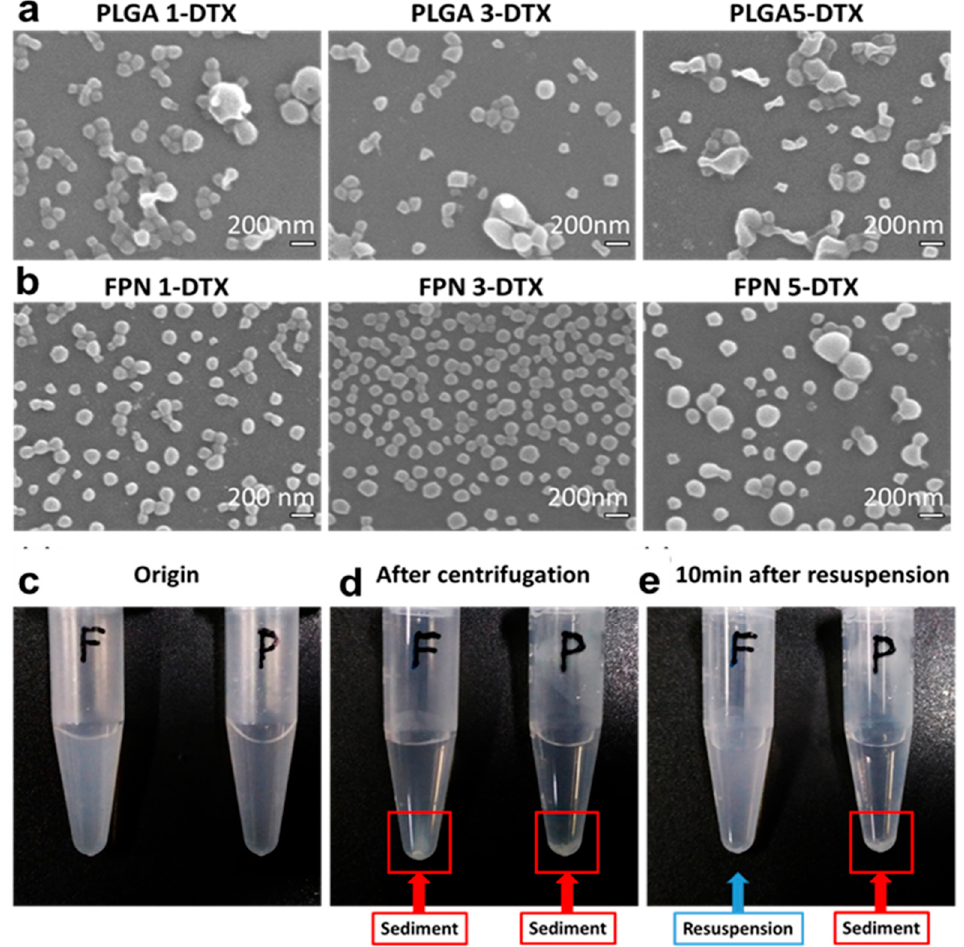
Figure 2. ( a ) SEM images of particles prepared without fucoidan (PLGA-DTX) compared with particles prepared with ( b ) fucoidan (FPNs–DTX). The concentration of PLGA in PLGA 1, PLGA 3, and PLGA 5 is equal to FPN 1, FPN 3, and FPN 5 respectively. Photograph of nanoparticles (FPN 3- DTX (F) and PLGA 3-DTX (P)) dispersive in DDW. In different states ( c ) the origins, ( d) after